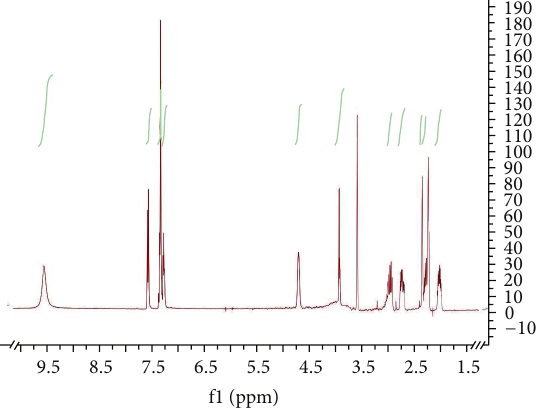
Figure 7: NMR spectrum of the product of method A.